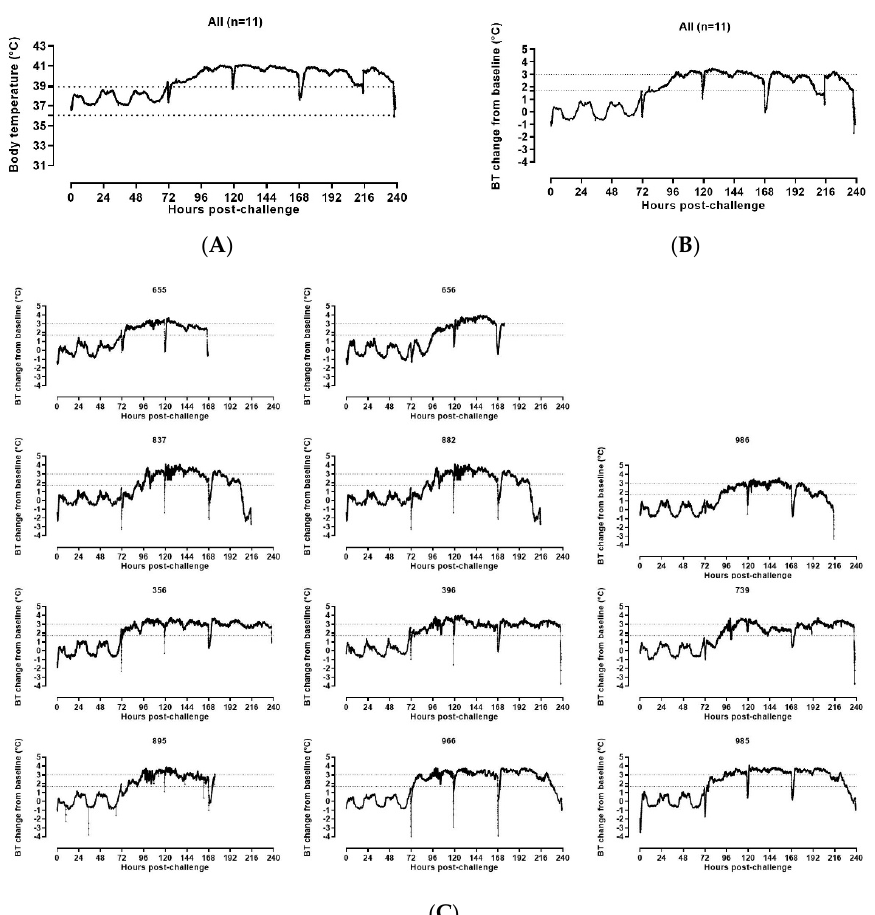
Figure 4. DSI telemetry body temperature changes in SUDV-challenged NHPs. ( A ) Group means DSI telemetry-based Body Temperature (BT) versus time. The dashed lines indicate the baseline minimum and maximum BT values. ( B ) Group mean DSI telemetry-based BT change from baseline versus time. The dashed lines indicate the BT change from baseline corresponding to fever ( ≥ 1.7 ◦ C) and hyperpyrexia ( ≥ 3 ◦ C). ( C ) DSI telemetry-based body temperature (BT) change from baseline in individual SUDV-challenged animals versus time. The straight dashed lines indicate the BT change from baseline corresponding to fever ( ≥ 1.7 ◦ C) and hyperpyrexia ( ≥ 3 ◦